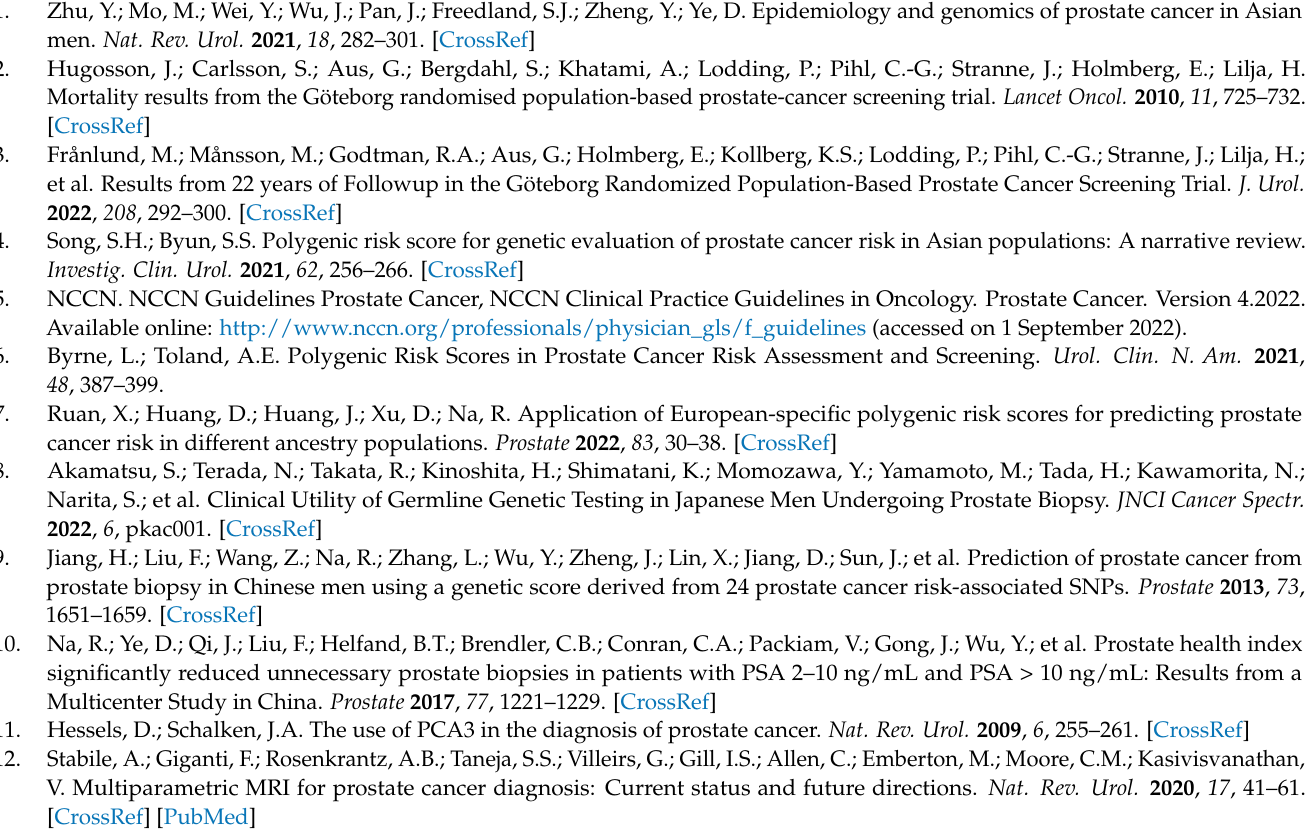
PRS. Figure S1. The PRS distribution in patients undergoing prostate biopsy. Figure S2. DCA curves of three different clinical risk models with PRS. Figure S3. Calibration histogram of phi-mediated